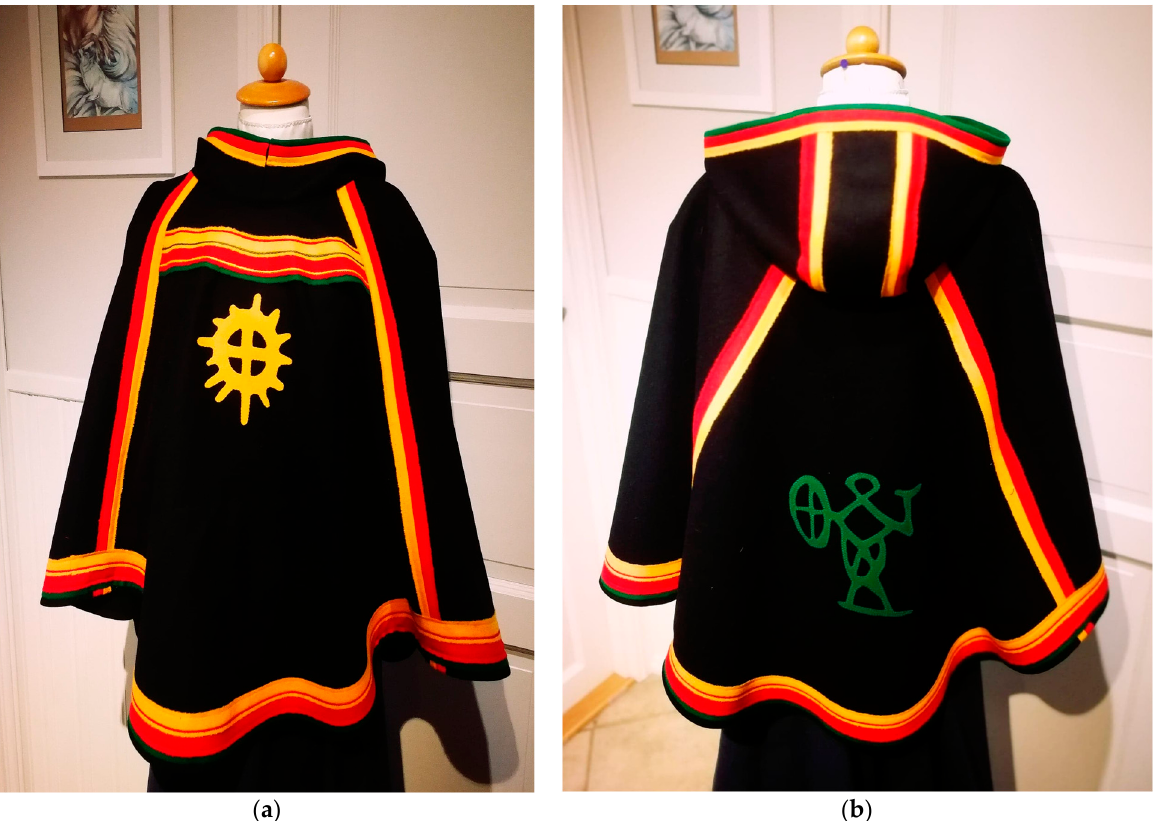
Figure 3. ( a ) the Saami beaivi (sun) symbol on the front and, ( b ) a noaidi symbol on the back. Luhkka made by Lone Beate Ebeltoft.